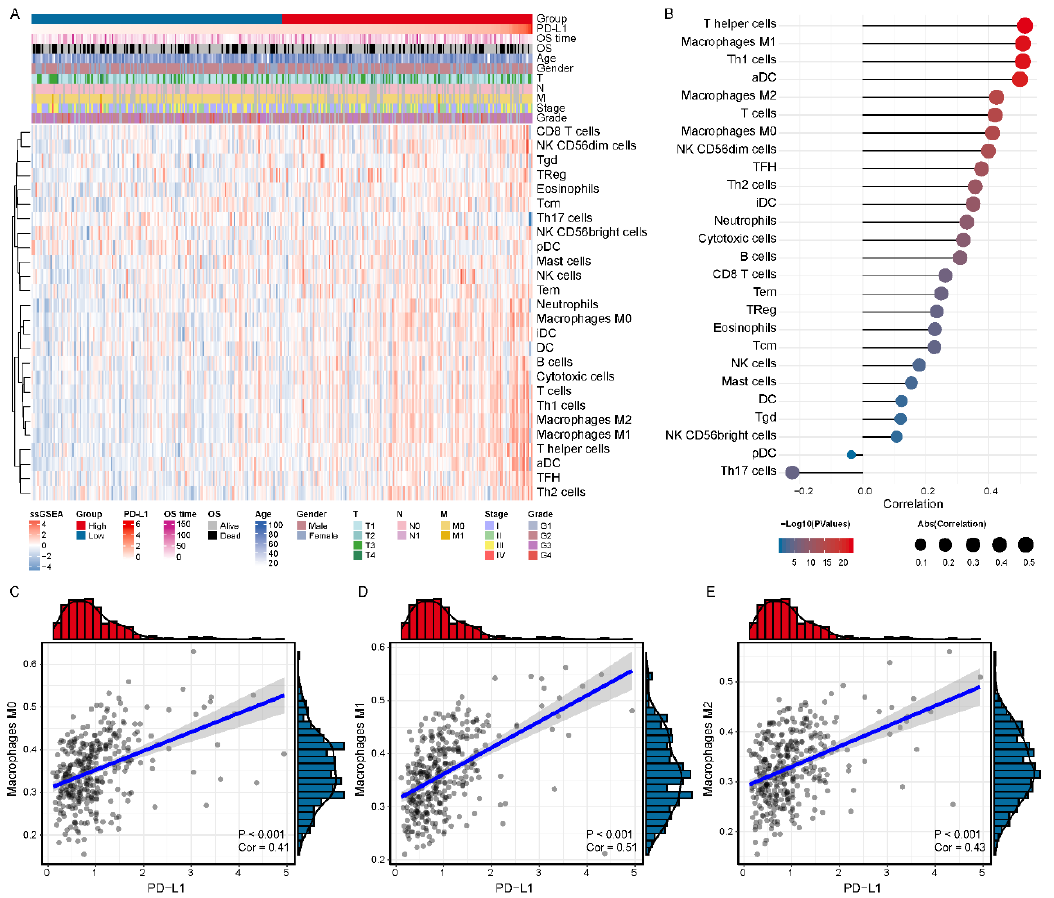
Figure 3. Association of the expression level of PD-L1 with the infiltration level of immune cell subpopulations in the TCGA LIHC cohort. ( A ) The immune landscape of HCC. ( B ) The relevance of the expression level of PD-L1 and infiltration level of immune cells. ( C – E ) The significant positive correlation of PD-L1 and tumor-associated macrophages (M0, M1 and M2), respectively.